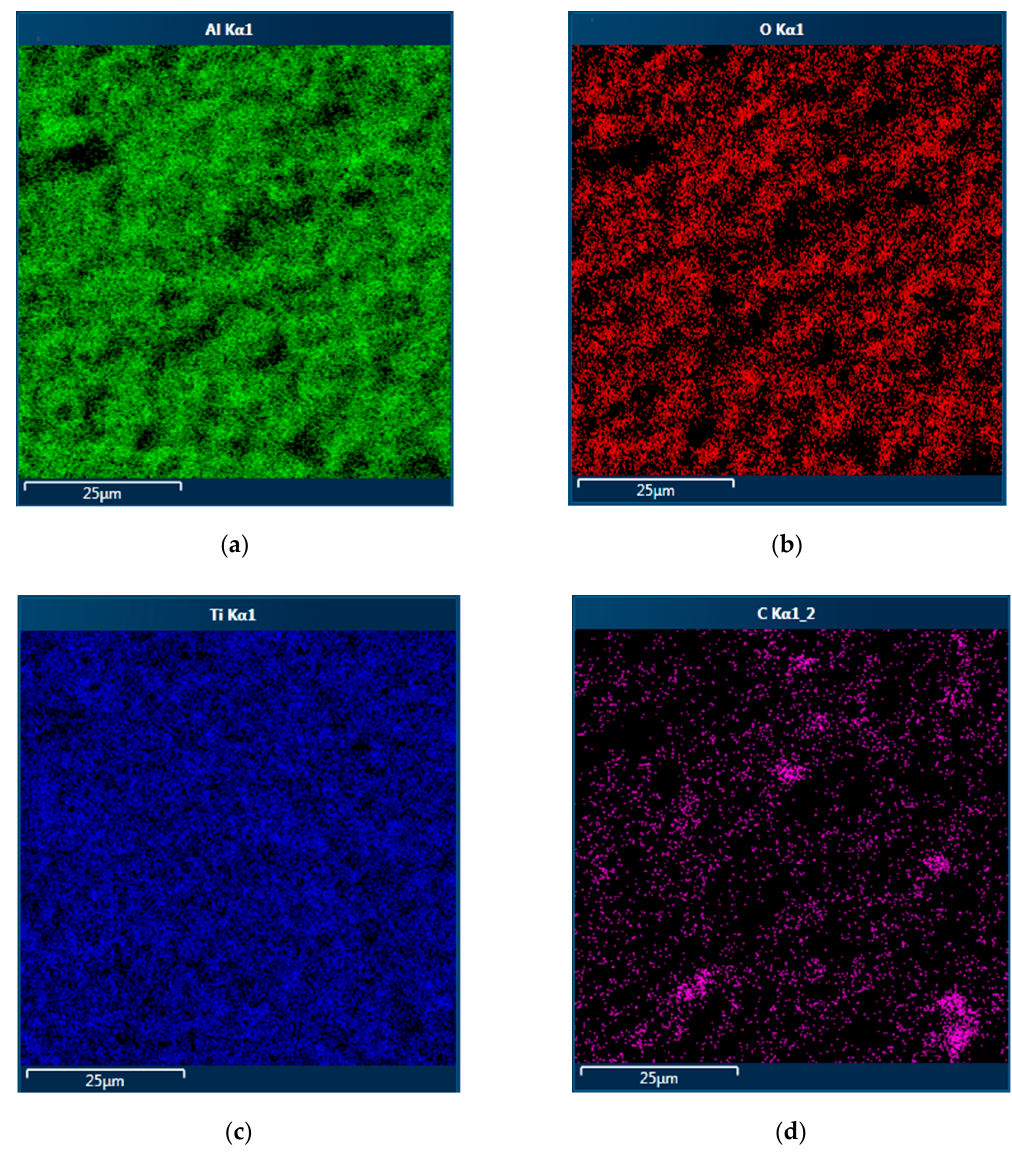
Figure 7. Elemental mapping of the Al 2 O 3 + 30%TiC nanocomposite machined surface in oil medium: ( a ) Aluminum; ( b ) Oxygen; ( c ) Titanium; ( d ) Carbon.